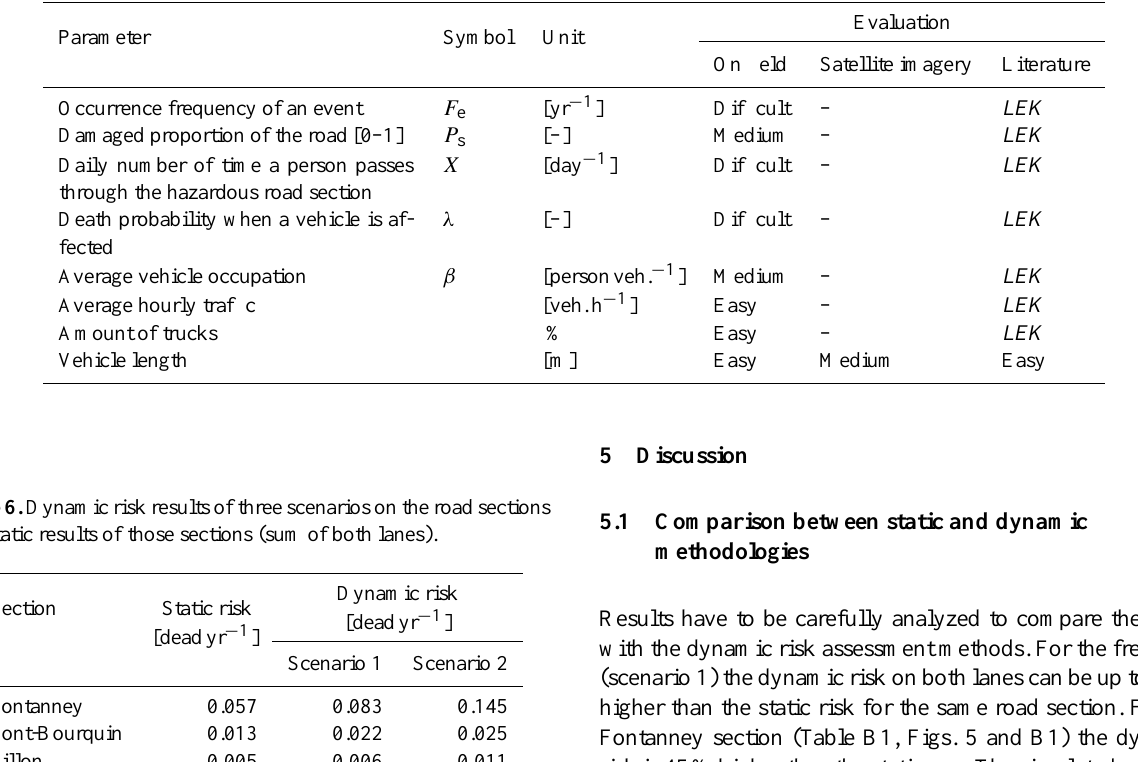
Table 5. Risk and traffic parameters values of the simulations described in this paper. For each parameter, an evaluation scale is estimated with three degrees depending of three different methods of evaluations (see Table 4 for details).